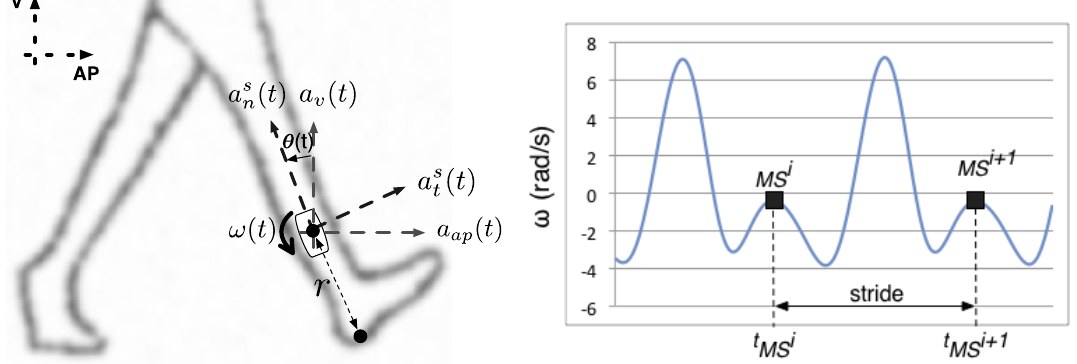
Figure 1. Sensor placement ( left ). Normal and tangential accelerations ( , ) and rotation speed ( ω ( t )) are sampled from an inertial sensor attached to the external face of the shank, at an intermediate point between the knee and the ankle. Local maxima of lower lobes of shank rotation speed are used to segment the whole signal into single strides ( right ). MS stands for Mid